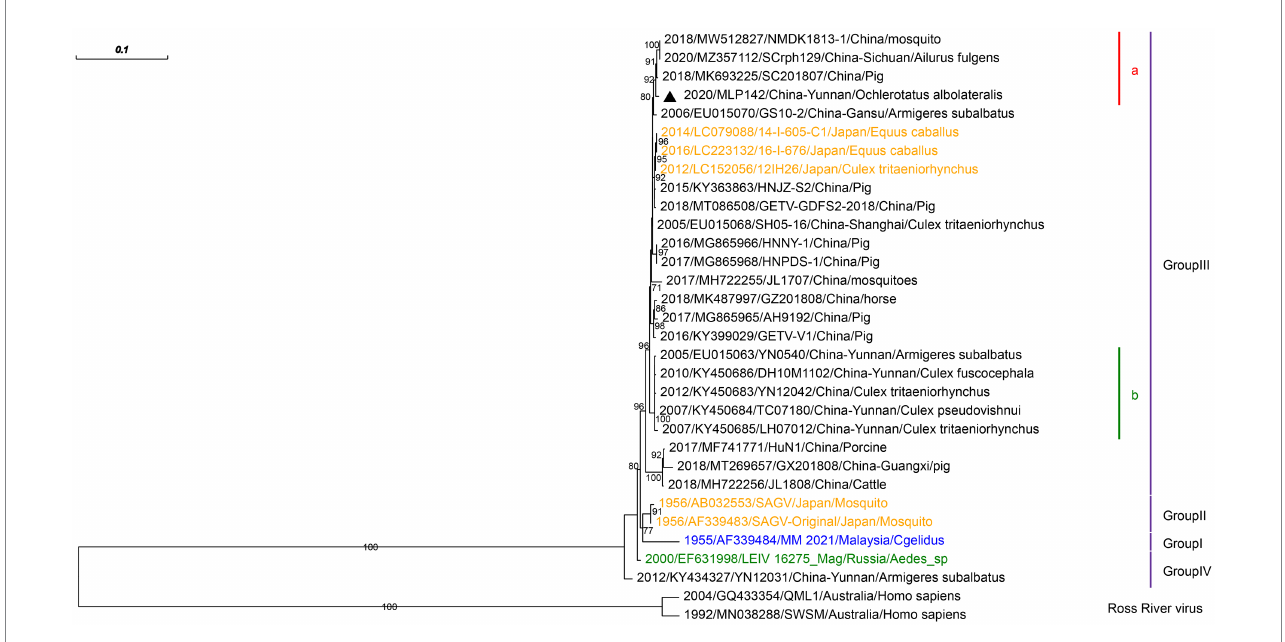
FIGURE 4 Phylogenetic analysis based on the nucleotide sequence of the E2 gene sequences (948 bp) of GETV. The phylogenetic tree was constructed by the maximum likelihood statistical method using IQtree v2.2.0 software. Bootstrap values were obtained from 1,000 replicates. Each GETV sequence is denoted by year of isolation, GenBank accession number, strain, country of origin and isolation source. The sequences obtained from mosquitoes collected in Malipo county in this study are denoted by black triangle. Sequences from Malaysia, Japan and Russia are indicated in blue, orange and green, respectively. Different clades are marked with different colors on the right. Branch scale bars are shown as 0.01 substitutions per